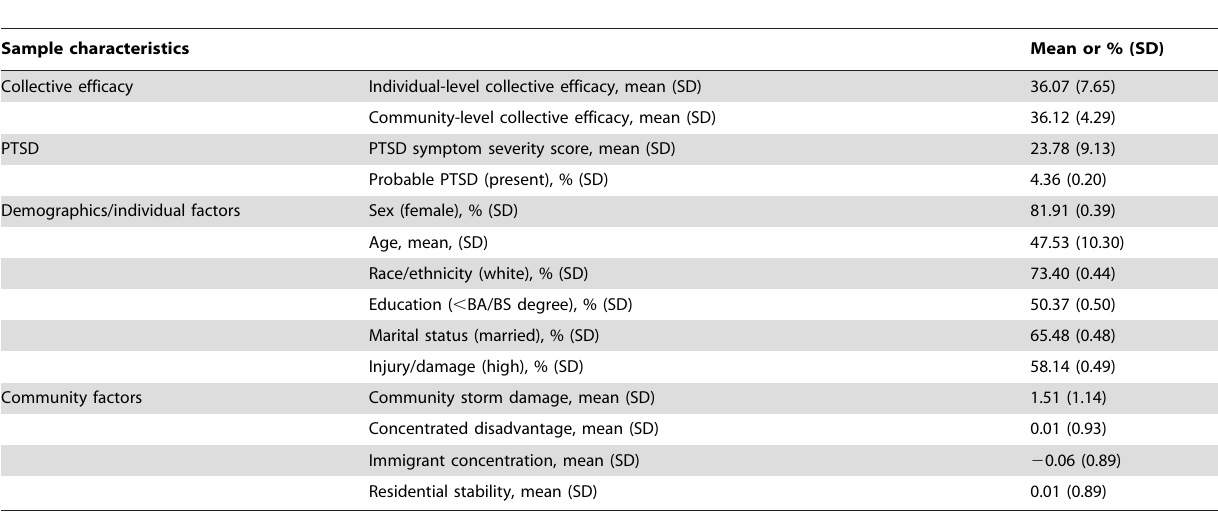
Table 2. Sample characteristics for collective efficacy, PTSD, individual and community factors (n =1880).